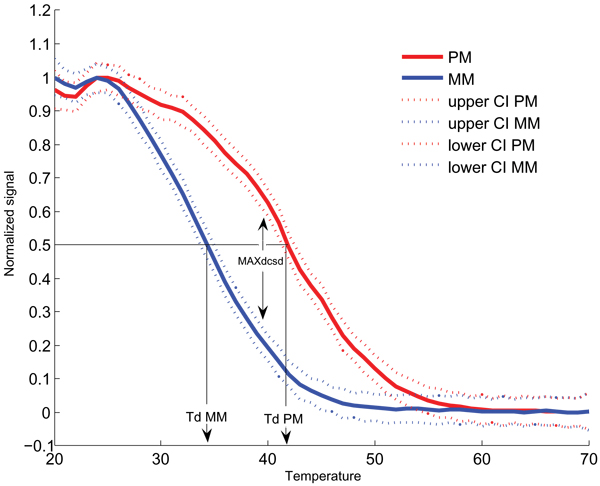
Mean melting profiles of perfect-match and mismatch probes using Alexa 594-labeled rRNA from Streptococcus mutans of six replicates in three experiments. Perfect-match (PM) probe and mismatch (MM) probe have Td (50% of signal remaining during analysis) values of 41.7°C and 34.0°C, respectively. The 95% confidence intervals are shown as dashed lines and MAXDCSD is 0.36 and occurs at 40°C. All values were calculated using fANOVA, see text for details (Bugli, submitted).